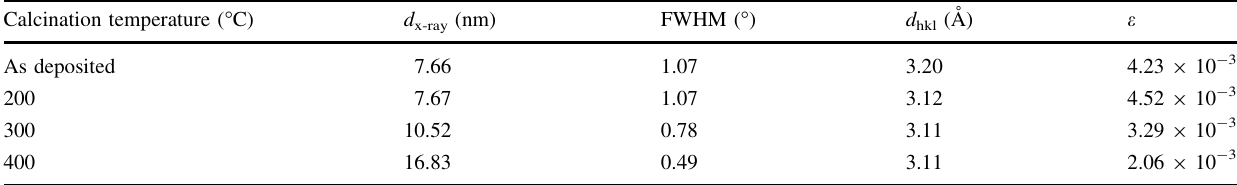
Table 2 Structural parameters, average grain size ( d x-ray ), full-width half-maxima (FWHM), inter-planar spacing ( d hkl ), and microstrain ( e ) for CZTS films Calcination temperature ( (cid:3) C)